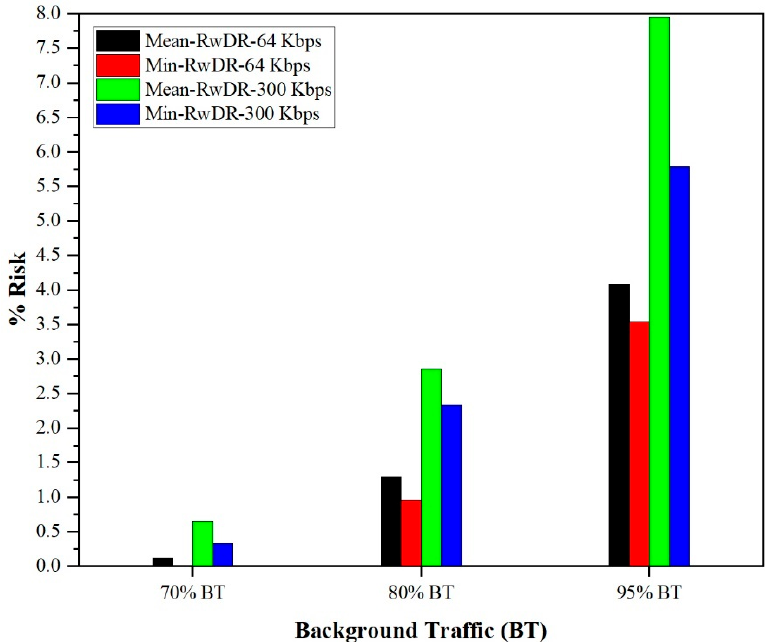
Figure 9. Effect of data rate on risk in shared SCN under varying BT.